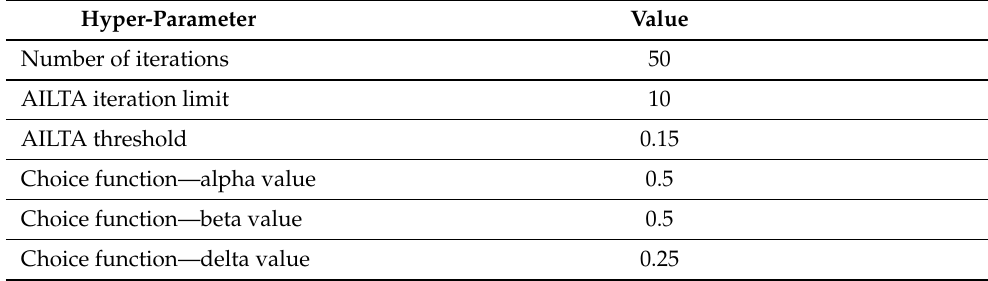
Table 4. The various hyper-parameters along with their values for the SPHH are listed in this table. Hyper-Parameter Value Number of